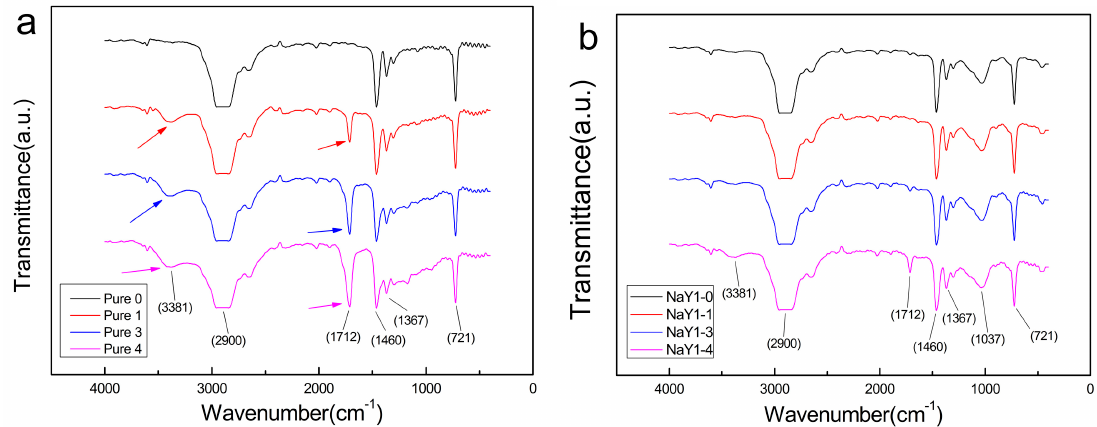
Figure 2. FTIR spectra of pure LDPE ( a ), zeolite / LDPE nanocomposite with nano-zeolite doping concentration 1 wt % ( b ) at 0, 1, 3 aging cycles.